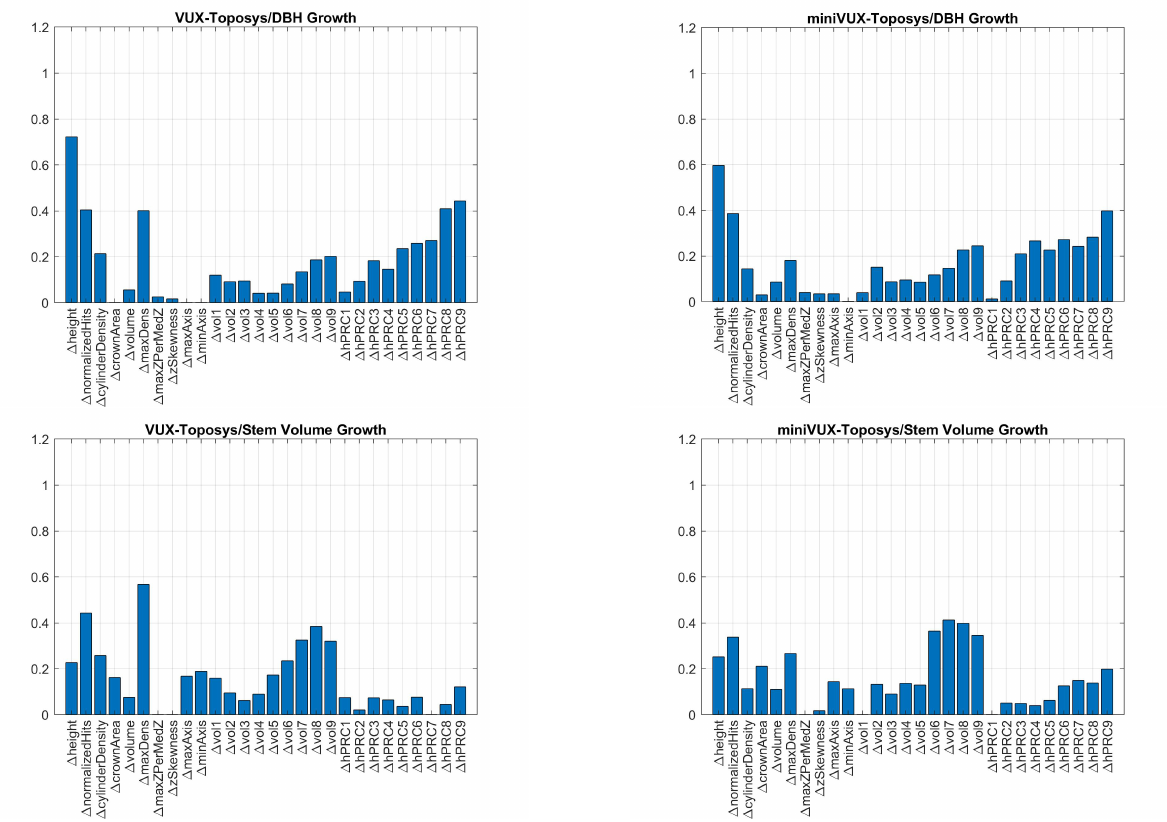
Figure 4. The feature importance of the random forest algorithm when predicting the growth directly. The letter ∆ refers to Equation (5), in which the variables are defined as the differences of the features in Table 4. The outcome of a prediction is the growth value, as defined in Equation (5).